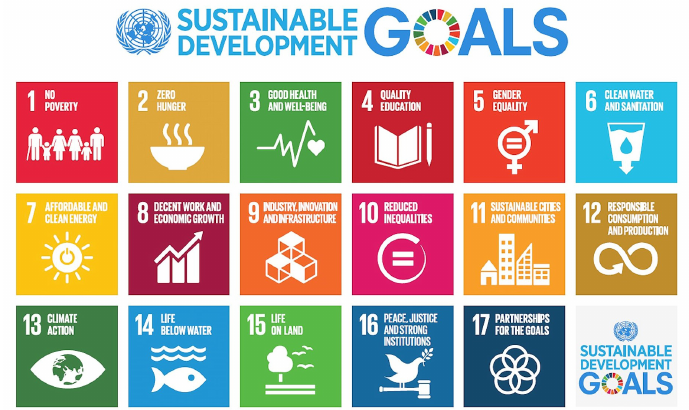
Figure 1. The United Nation’s seventeen Sustainable Development Goals (SDGs)